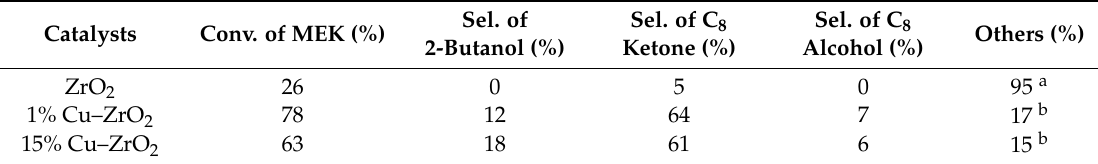
Table 2. Catalytic activity for the conversion of methyl ethyl ketone (MEK) to a desirable product (C 8 ketone) over several